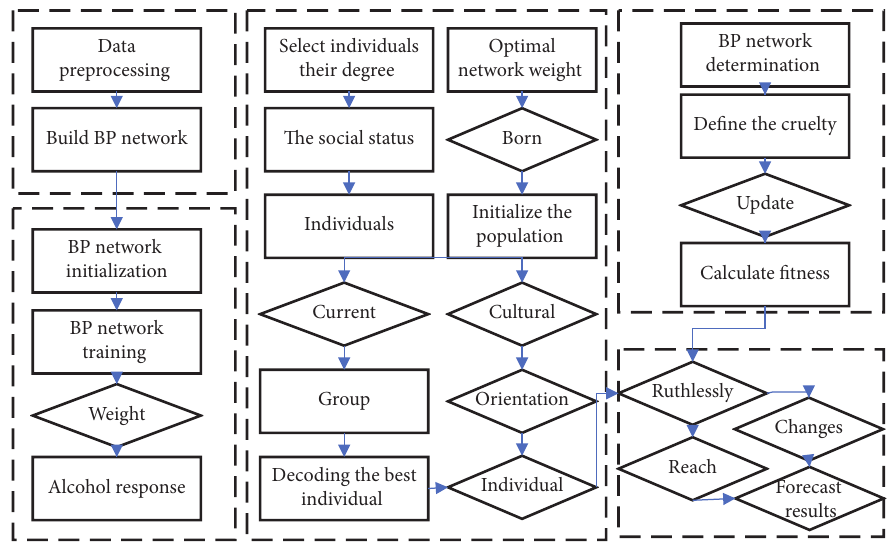
Figure 3: Flowchart of shallow neural evolution